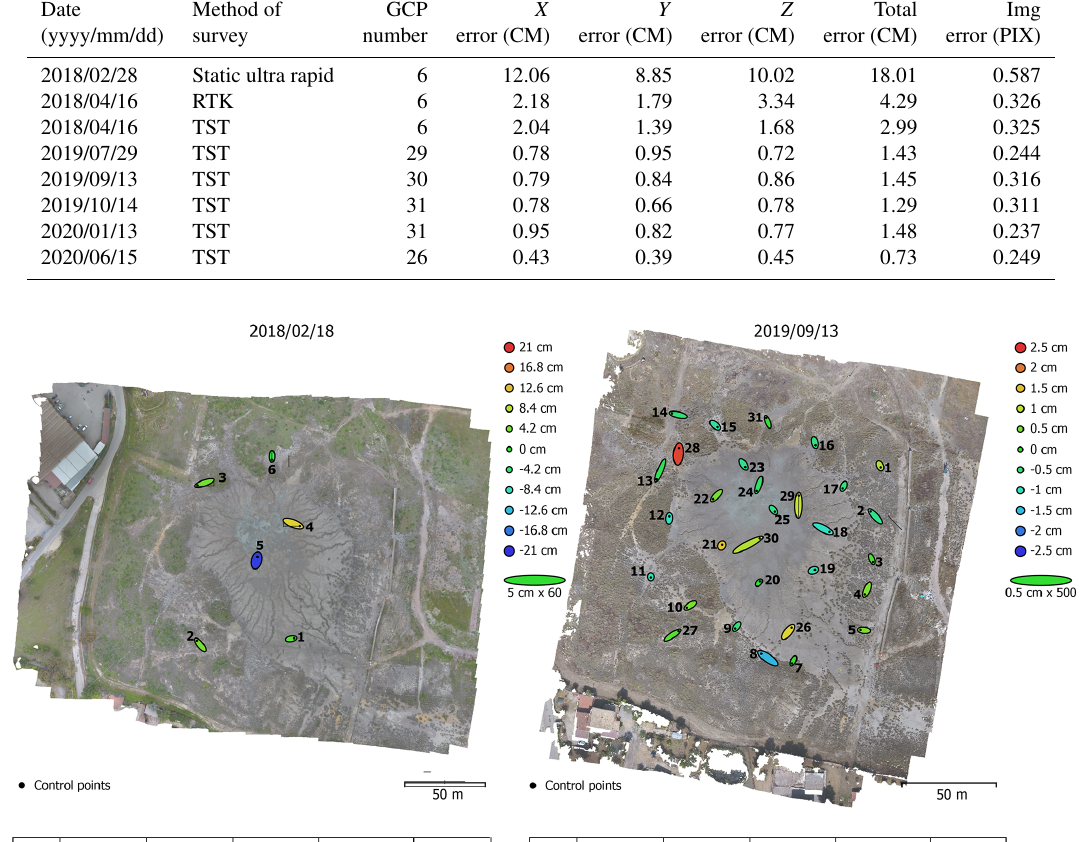
Table 1. Average RMSE of GCPs obtained for each survey and for each technique used to determinate the GCPs coordinates: X (easting), Y (northing), Z (altitude) and the total error. The image residual (“Img error” in the table) is shown.